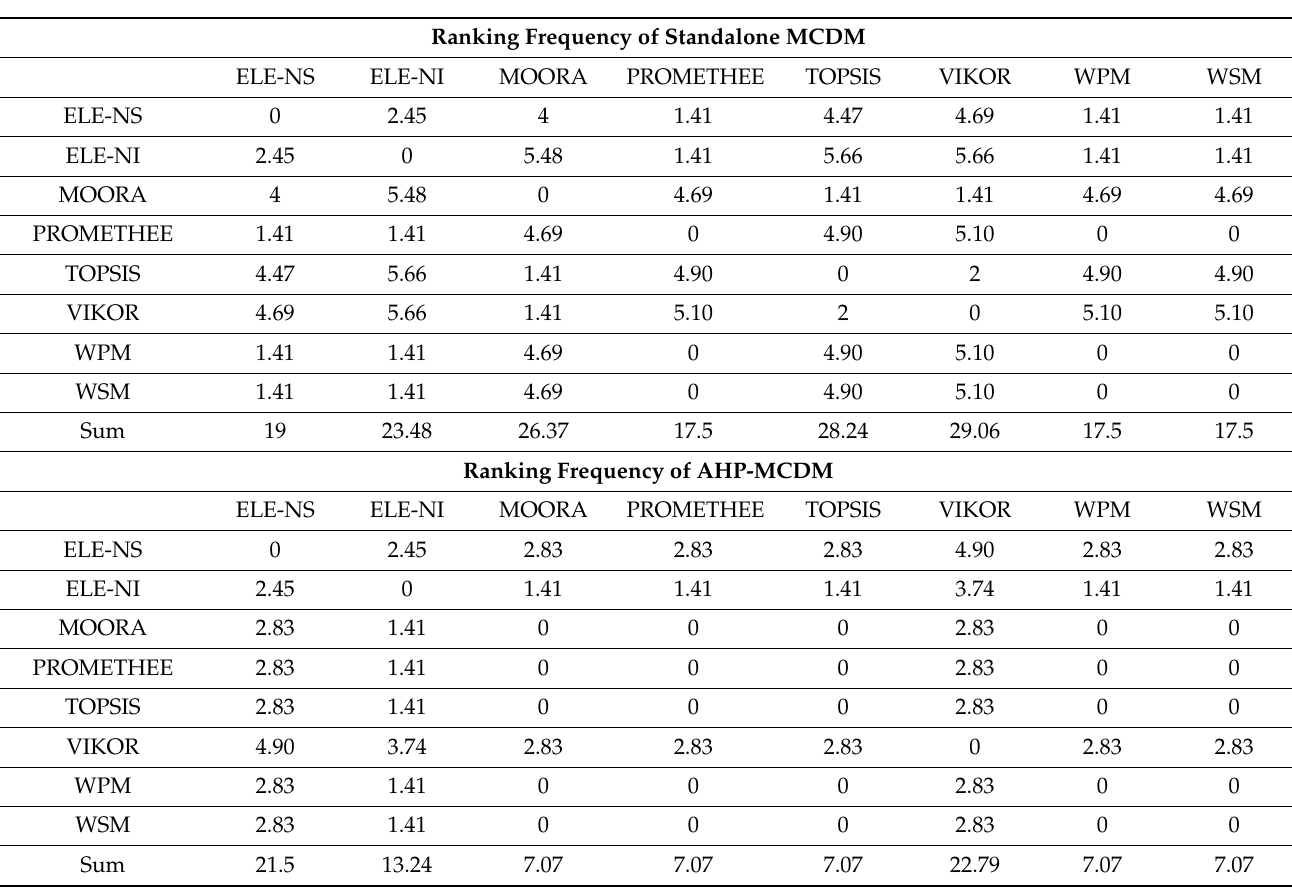
Table 8. Pairwise comparison of frequency error